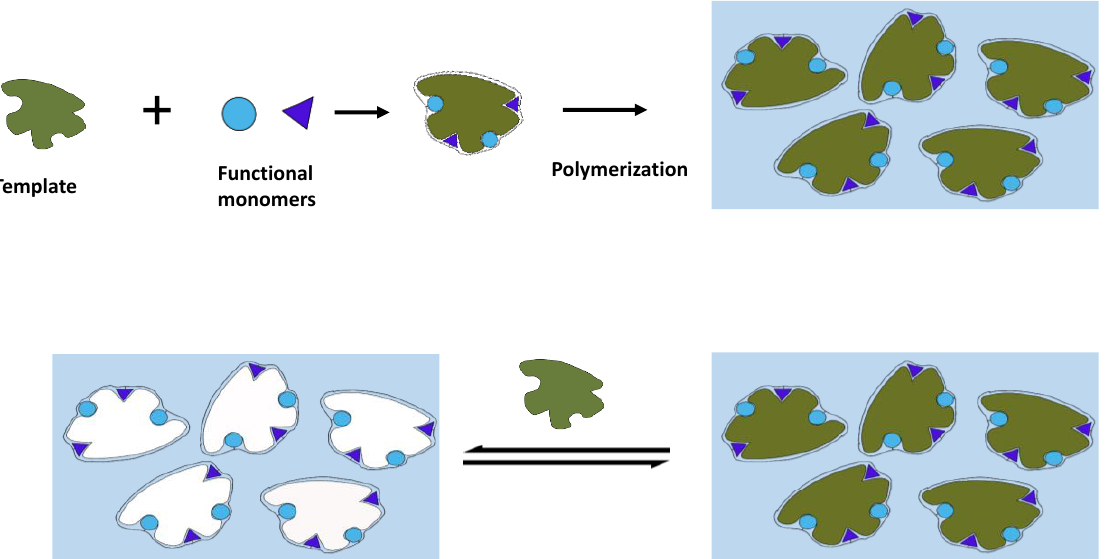
Figure 3. Schematic representation of fabrication of molecularly imprinted polymers (MIPs) for recognition of pathogens.